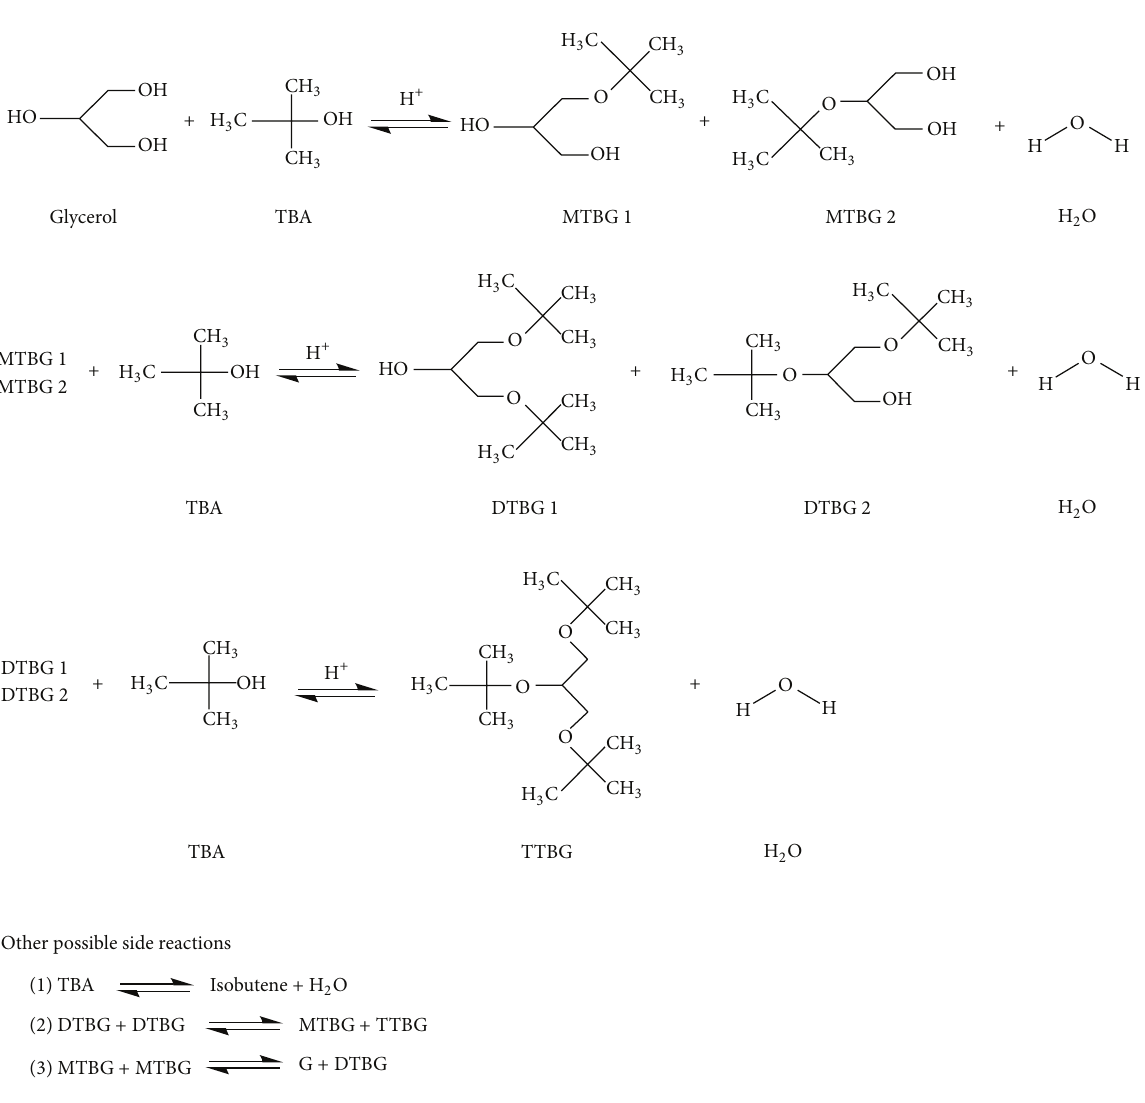
Figure 1: Tert-butylation of glycerol and side